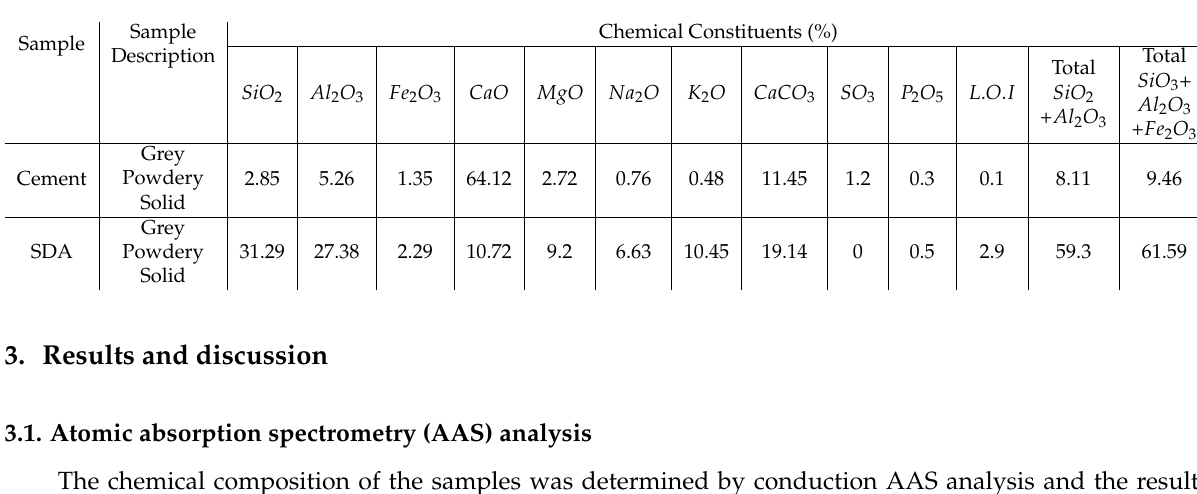
Table 1. Chemical composition of studied